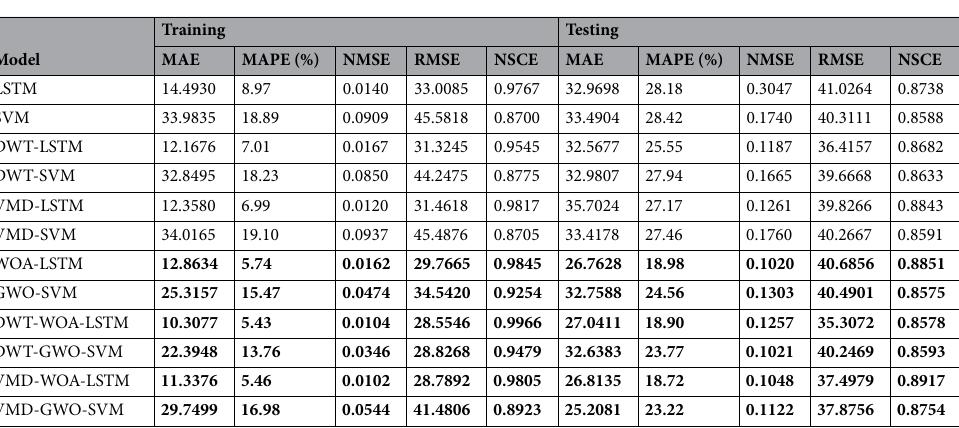
Table 4. The evaluation metrics in the training and testing